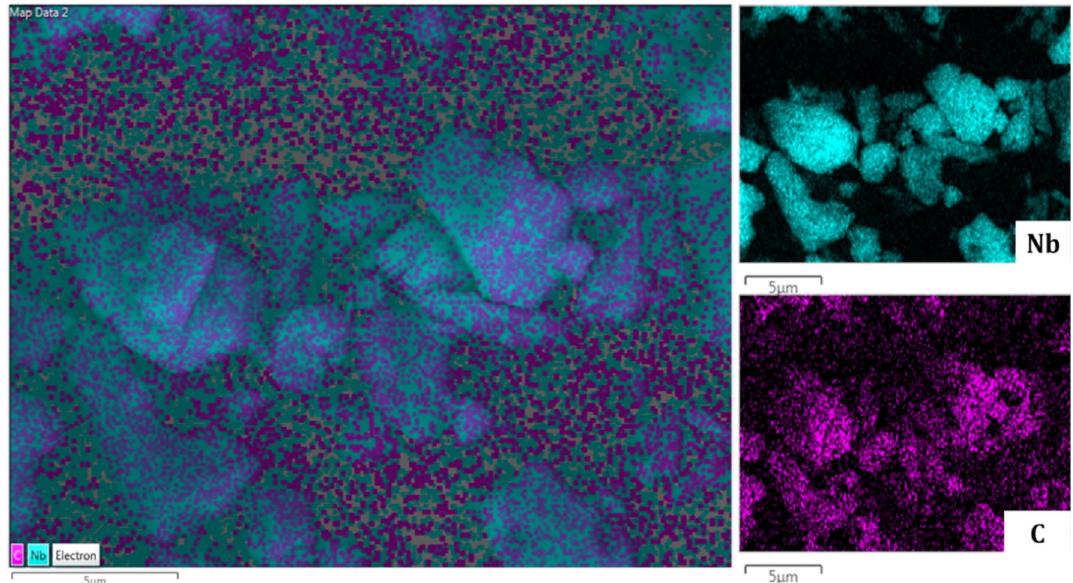
Figure 2. EDX elemental mapping of Nb 2 C MXene.